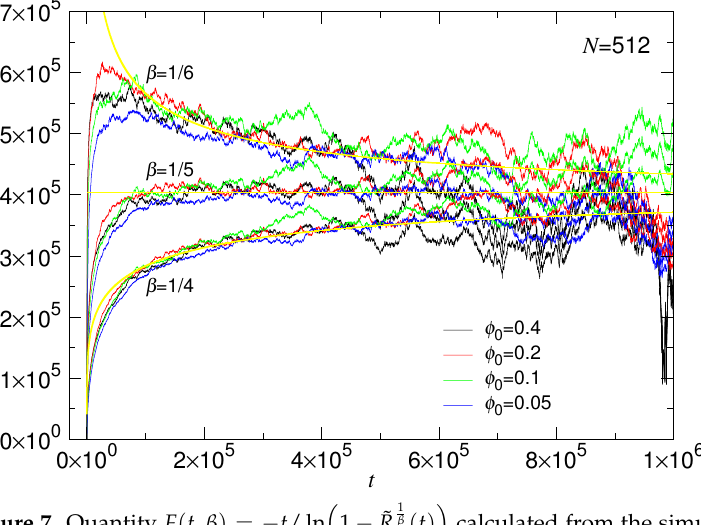
Figure 7. Quantity F ( t , β ) = − t / ln plotted against t at β = 1 F ( t , β ) are plotted in yellow color by assuming ˜ R ( t ) =